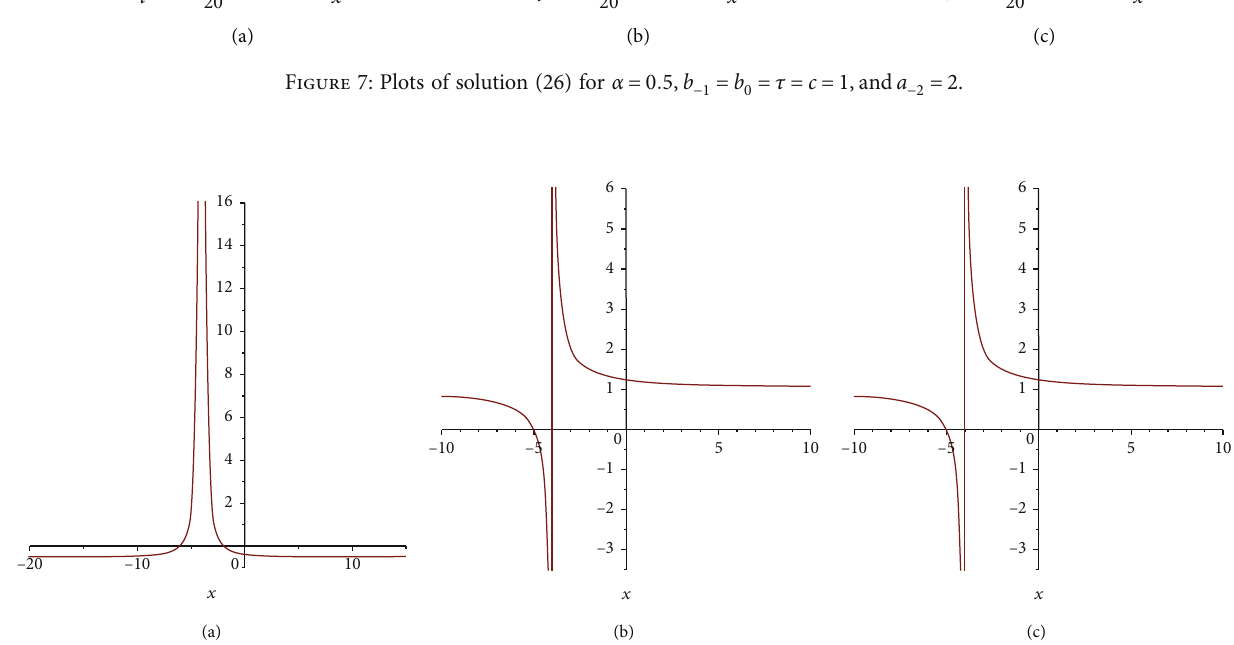
= b = τ = c = t = 1, and a − 1 0